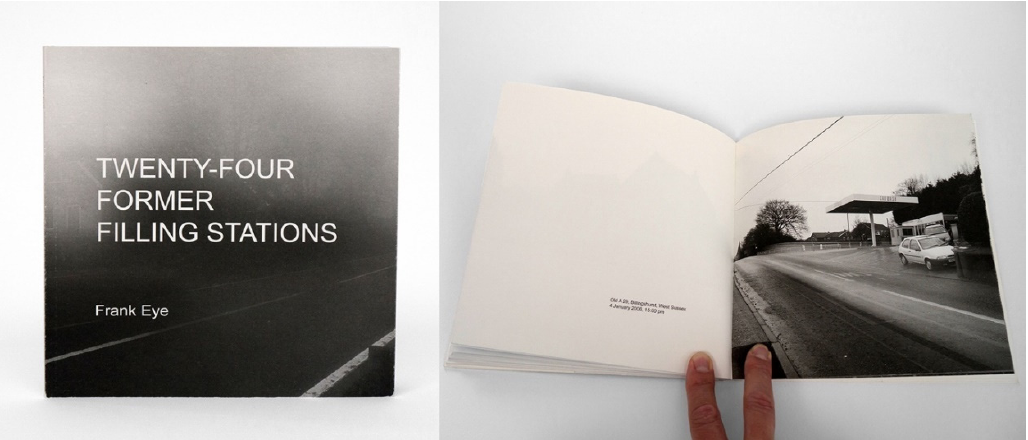
Figure 14. Frank Eye, Twenty-Four Former Filling Stations , 2005.